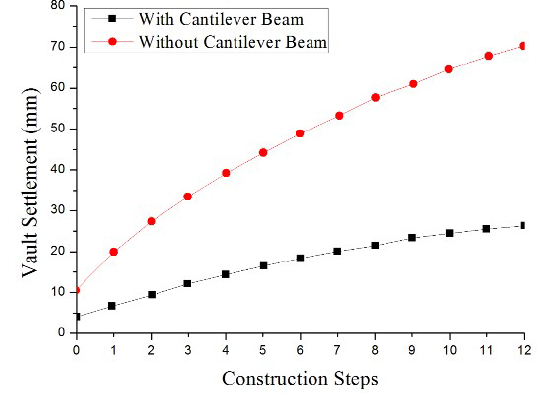
Figure 10. Relation curve of the cantilever beam angle and vertical displacement of the vault.